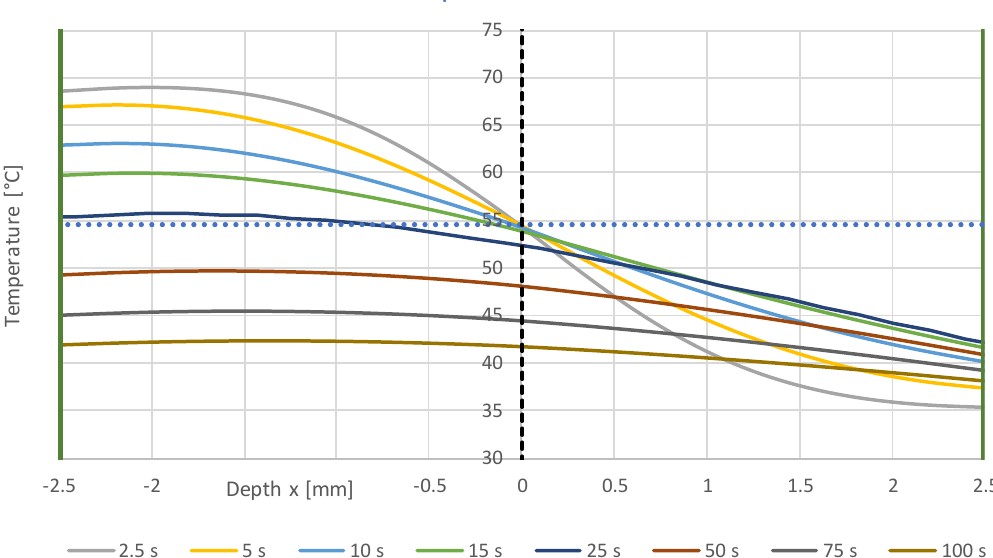
Figure 7. Temperature profiles for equal times t from 2.5 s to 100 s above the local coordinate x for a cylindrical sample of boiled potatoes 2.5 mm thick and 70 °C starting temperature in contact with the tongue. Tongue temperature: 35 °C.